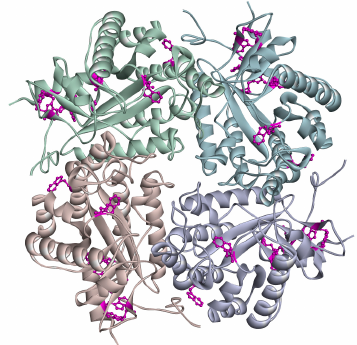
Figure 2. Representation of puuE tetrameric assembly (Protein Data Bank 3cl6). Monomers are shown as solid ribbons in different colors, while tryptophan residues are evidenced in purple ball and stick.